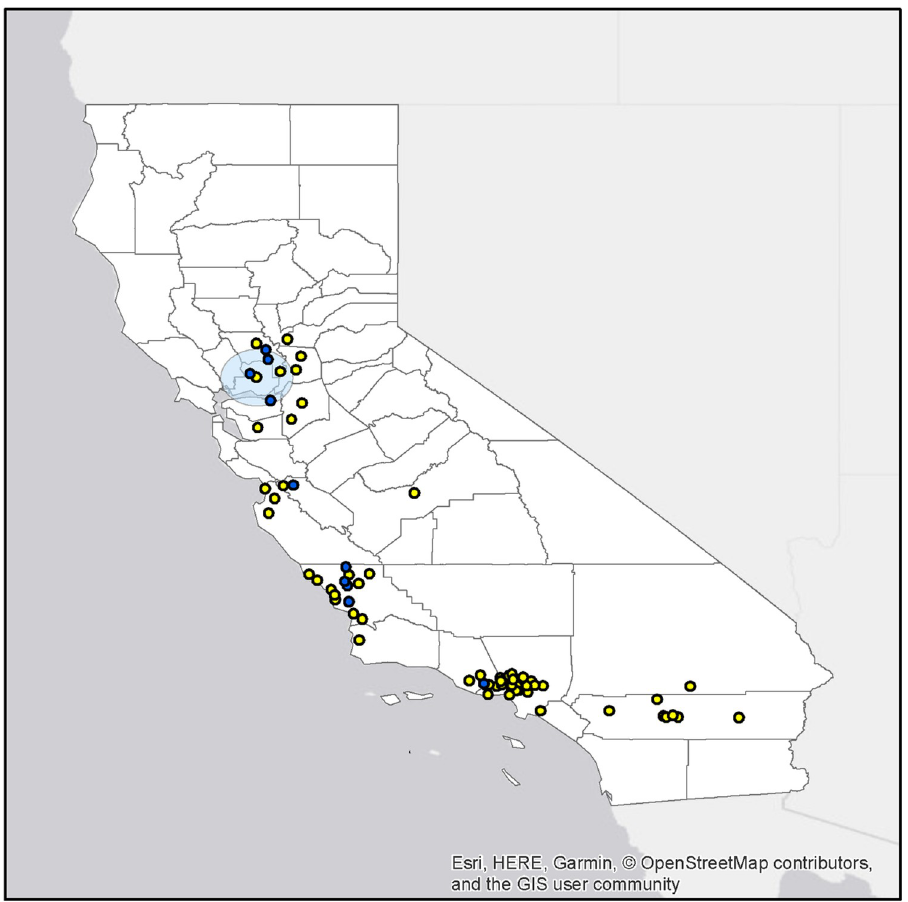
Fig 3. Map of the significant spatial cluster of Chlamydia spp. seropositive raptors by EBA and/or IFA in northern California. Distribution of seropositive raptors (blue) and seronegative raptors (yellow; Center, 38.310500 N, 121.901800